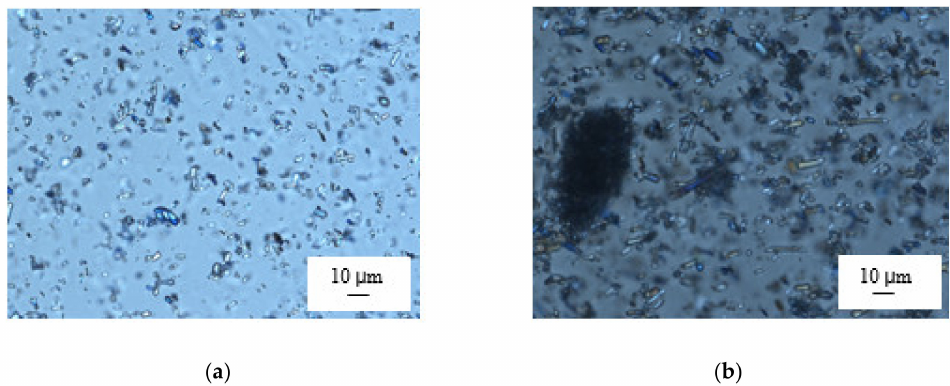
Figure 2. Microscopic image of the LO suspension (30% w / w ) in the HPMC casting mass homogenized in a planetary mixer, Thinky ( a ), or in Ultra-Turrax ( b ); the scale bar is 10 µ m.